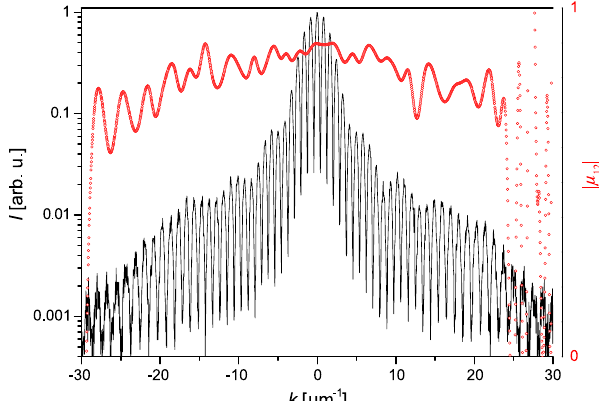
Figure 3. Modulus of the complex coherence factor depending on k . The fringes (black solid line) obtained using a slit spacing of d = 0.92 µ m show excellent contrast up to high momentum transfers. The slight degradation in the mutual coherence factor or fringe visibility (red dots) can be attributed to a limited dynamic range of the detector (~10 3 ).